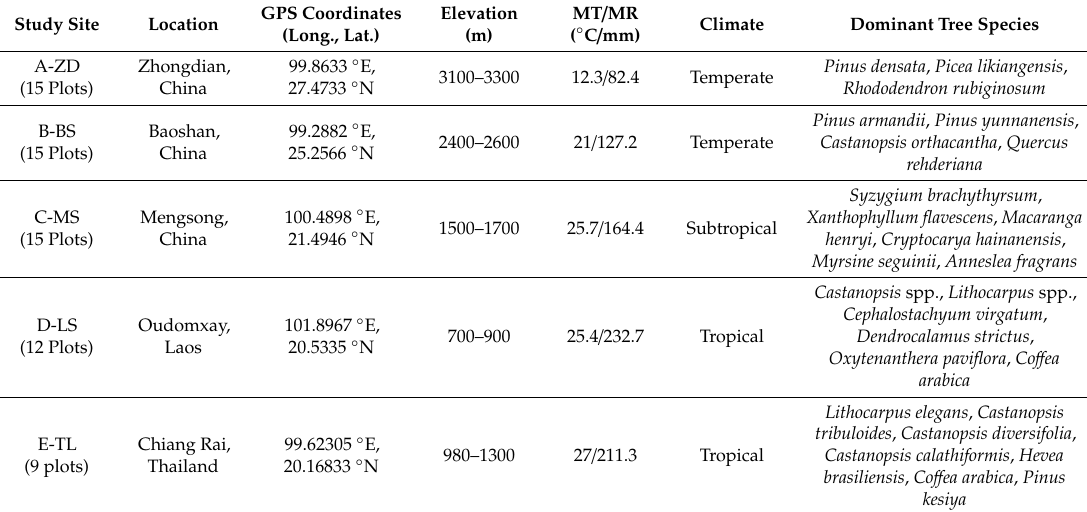
Table 1. Background information for each study site: Global Positioning System (GPS) coordinates, elevation (m), climate type, mean monthly temperature (MT, June–October 2014), mean monthly rainfall (MR), and dominant tree